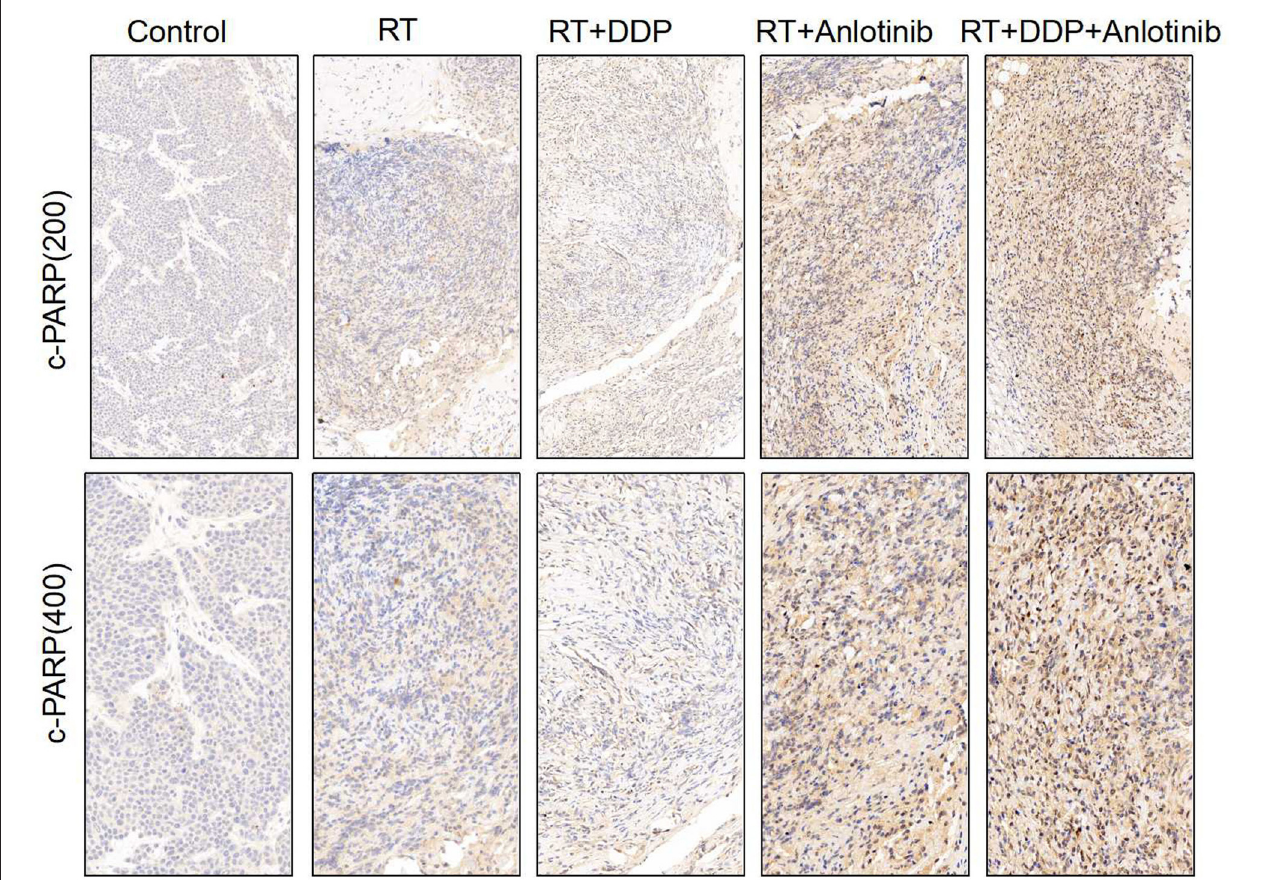
FIGURE 7 | Representative images for c-PARP immunohistochemistry show that brownish yellow nuclei and cytoplasm staining, respectively, indicate the positive cells. Varying degrees of positive rates were shown for the four treatment groups in which anlotinib combined with chemoradiation-treated group was the highest compared with the control group. The figure provided is a representative image, and other images are provided in the Supplementary Files. RT, radiation therapy; DDP,